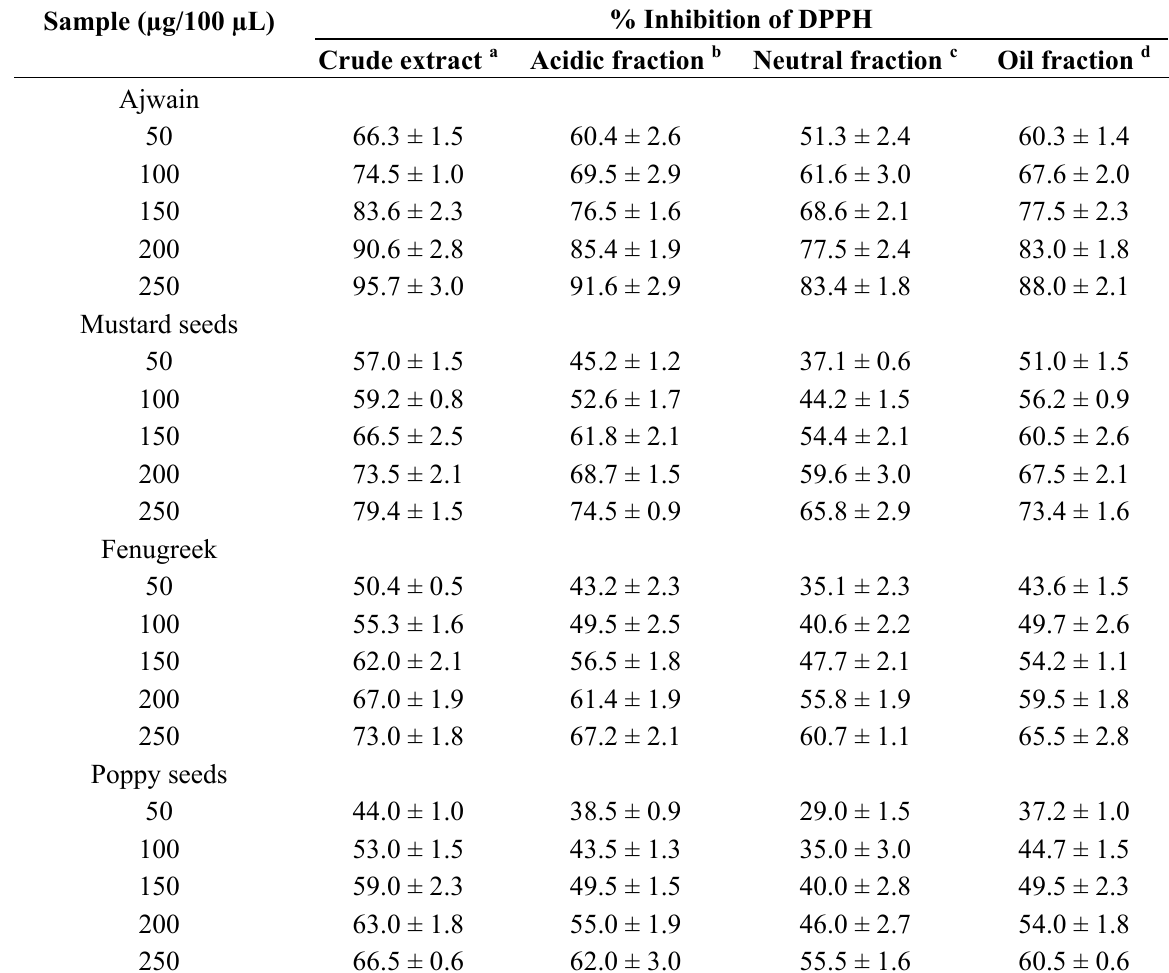
Table 3. DPPH scavenging activity of the crude extract, acidic, neutral and oil fraction. Sample (µg/100 µL)